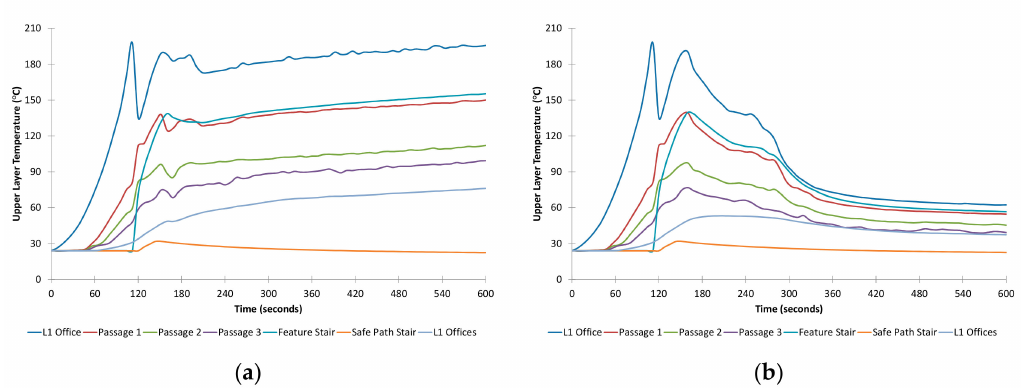
Figure 8. Upper layer temperature for compartments of CF5: ( a ) With window failure; ( b ) Without window